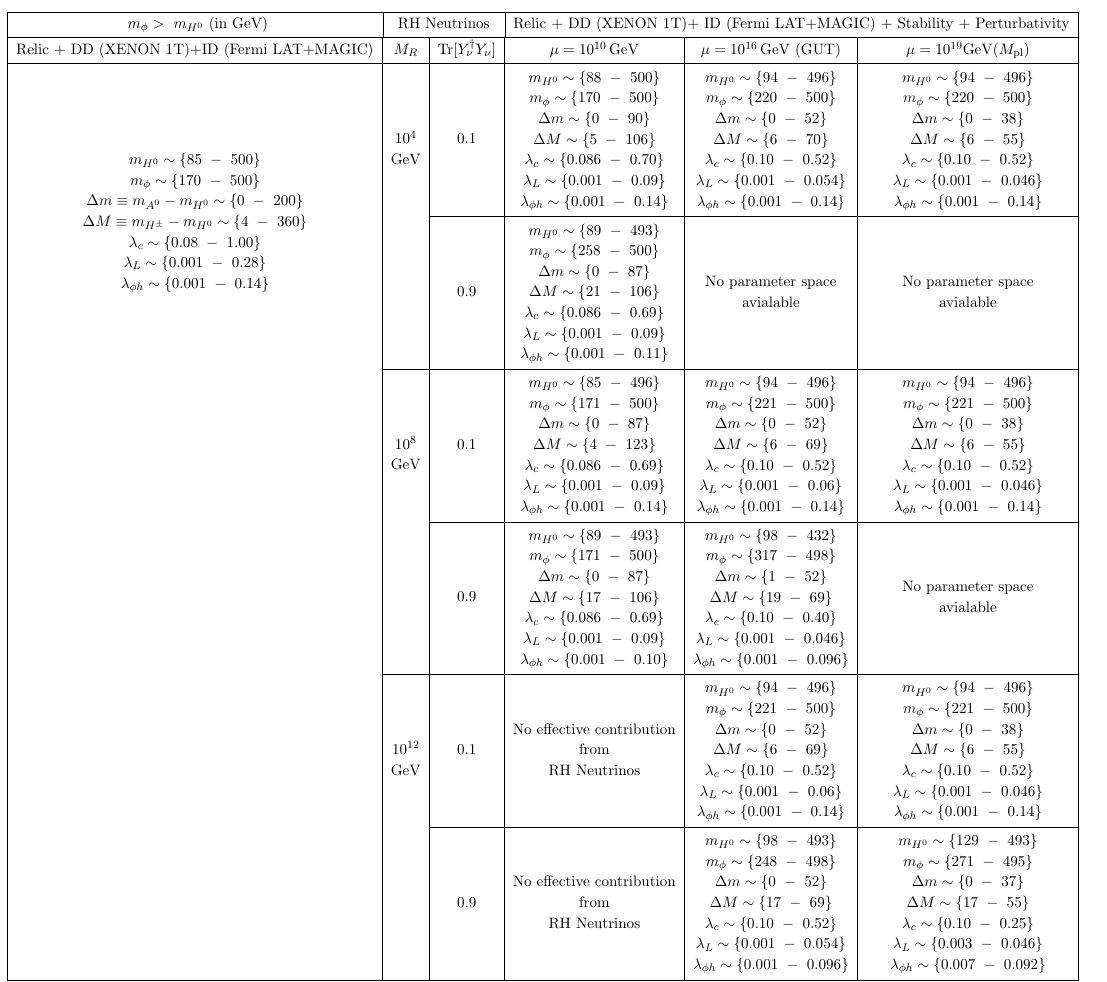
Table 9 . Allowed ranges of relevant parameters considering m (cid:30) > m neutrino mass and Tr[ Y y